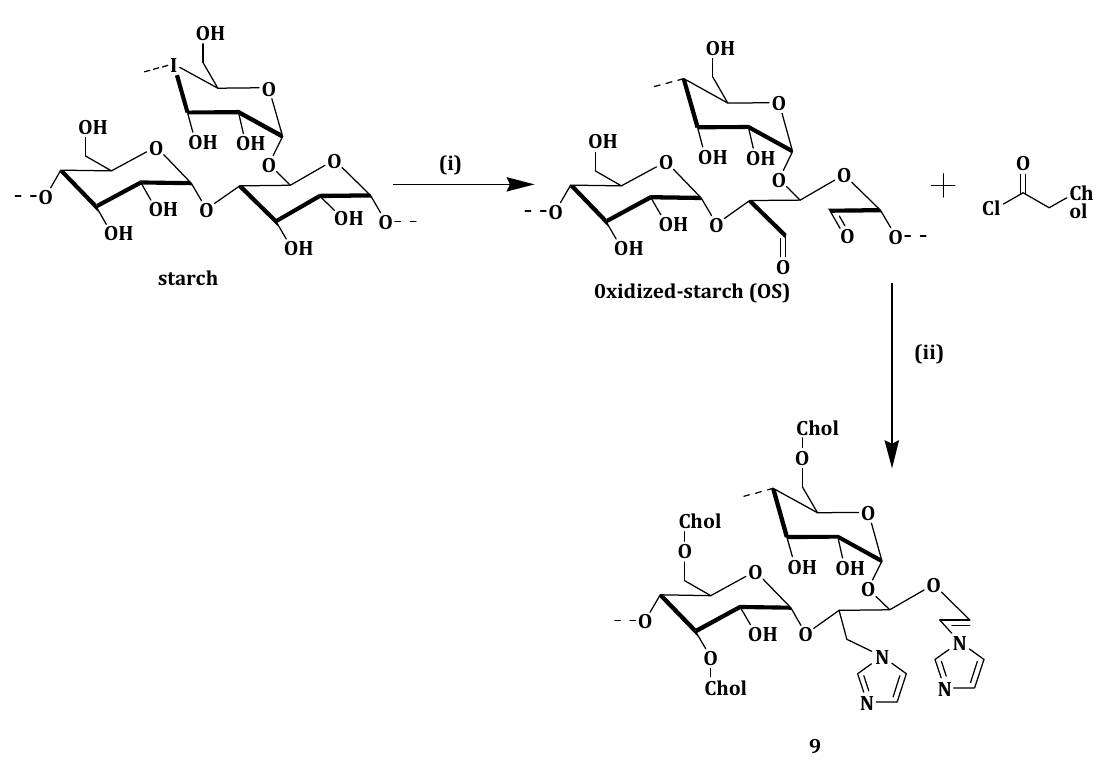
Table 1. Characterization of liposomes with different cholesterol